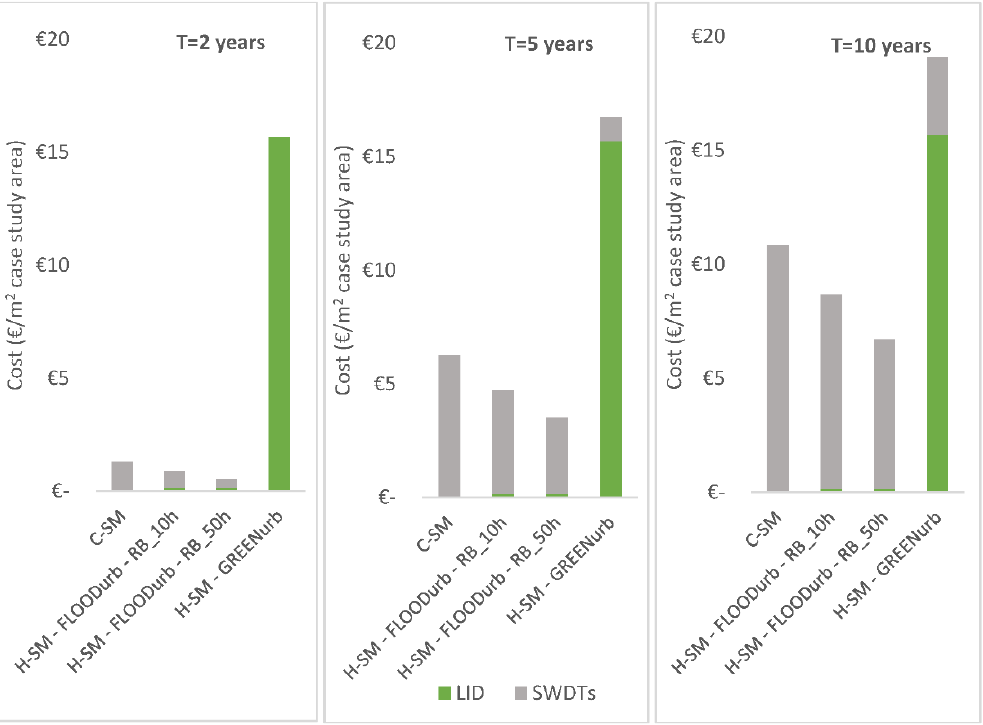
Figure 9. Mean reductions of stormwater volumes to be discharged into SWDTs (D).